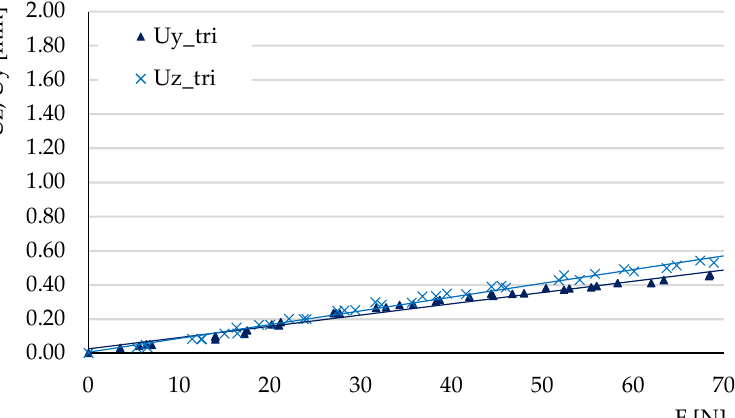
Figure 16. The variations of deflections Uy = f ( Fy ) and Uz = f ( Fz ) for the triangle structure, in experimental three-point bending.